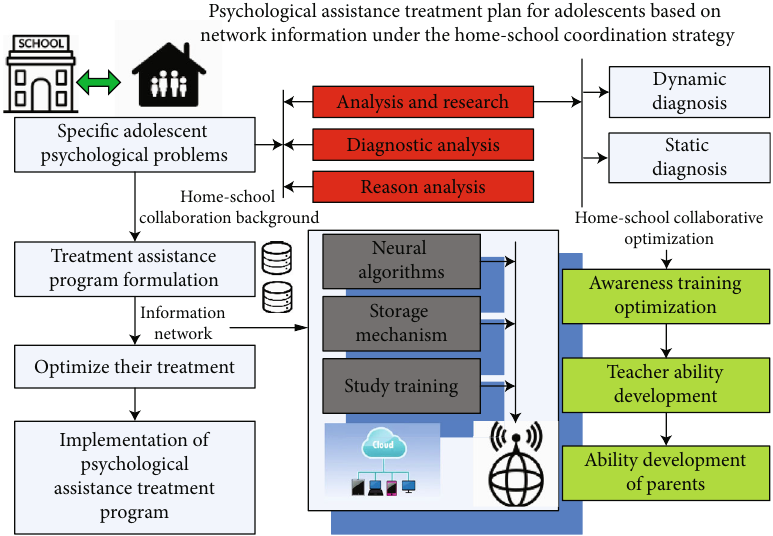
Figure 1: Framework of psychological assistance treatment scheme for adolescents based on network information under the home-school coordination